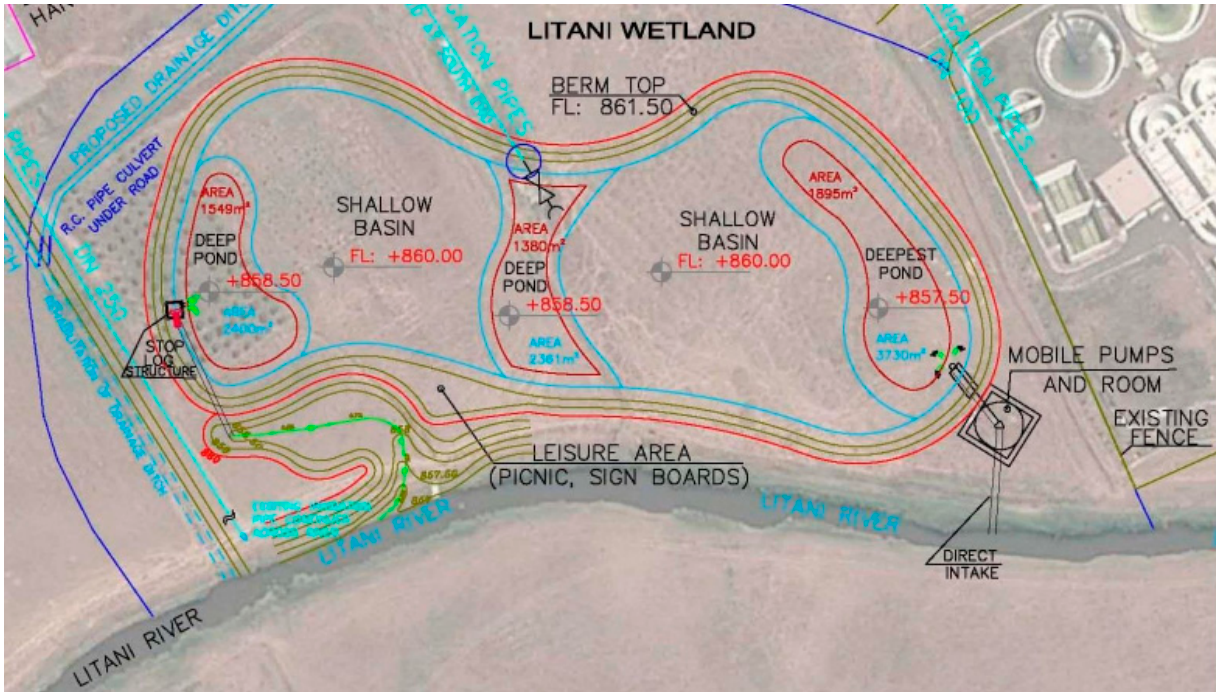
Figure 2. Overview of Litani River constructed wetland.